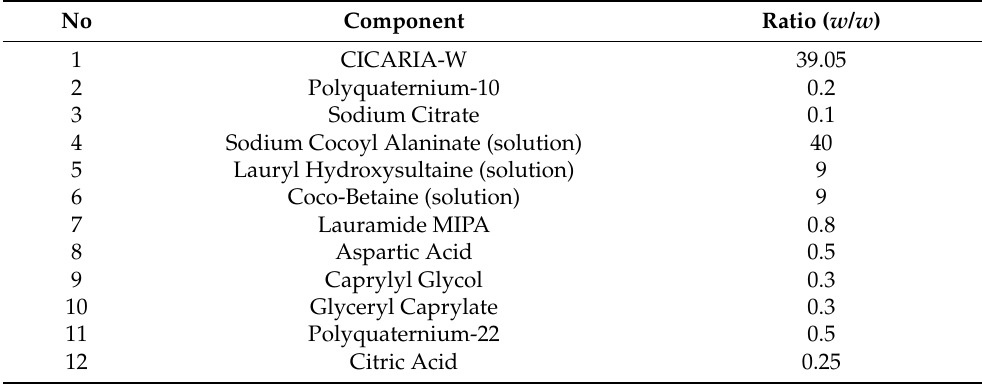
Table 3. Components of Cicaria shampoo.